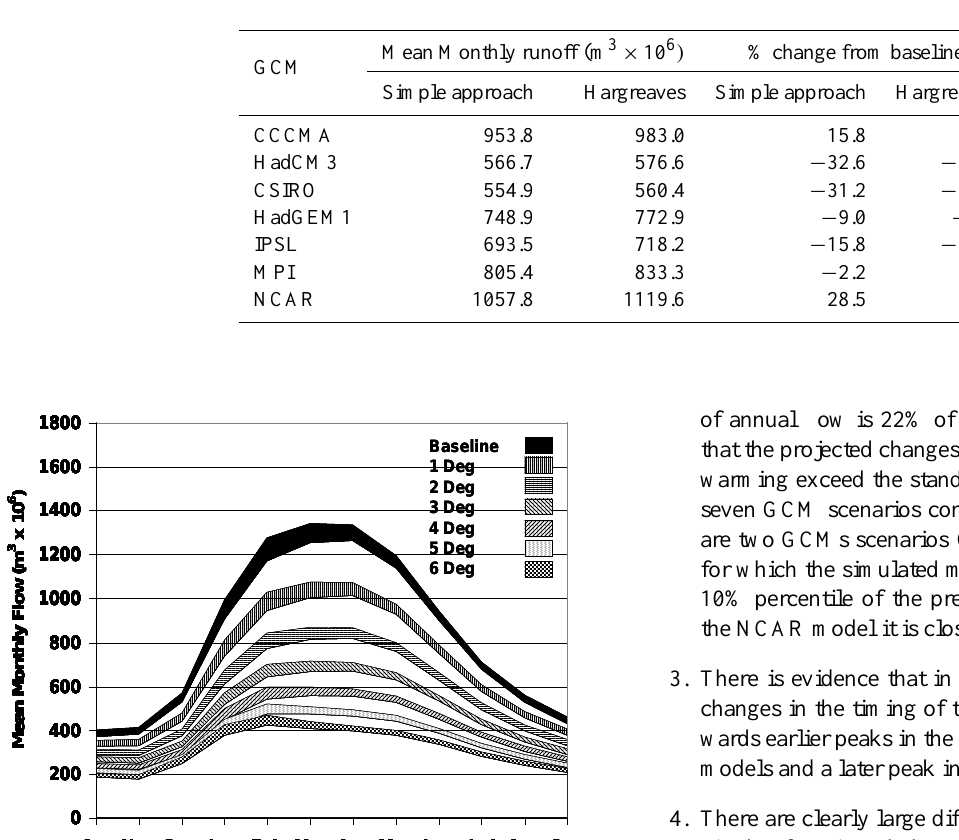
Table 2. Mean monthly runoff of the Okavango river at Mukwe (m 3 × 10 6 ) , and changes with respect to baseline conditions associated with a 2 ◦ C global warming using the simple potential evaporation approach versus the use of the Hargreaves estimation equation. The values are based on the mean hydrological parameter uncertainty ensemble in all cases.